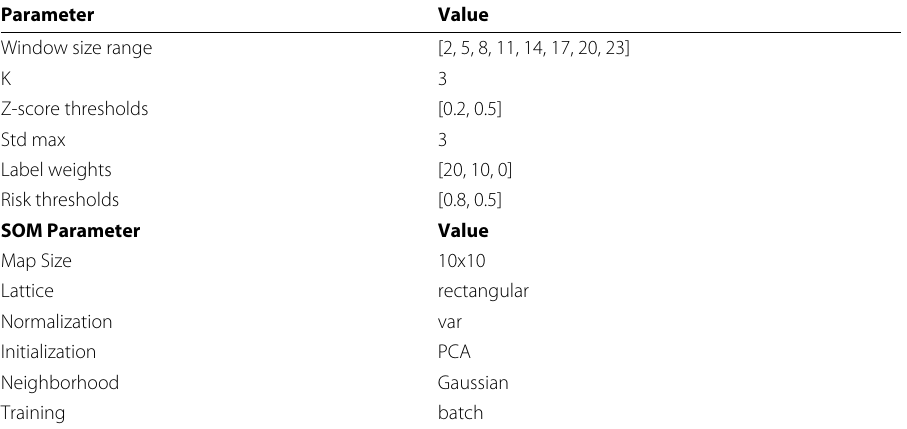
Table 4 Parameters used in the